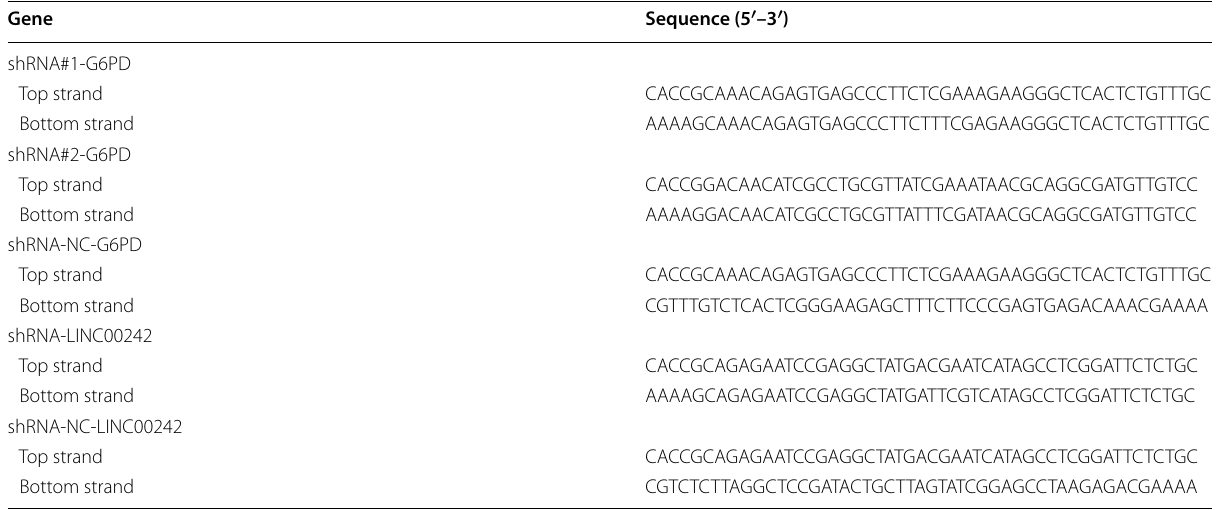
Table 2 ShRNA sequence of G6PD and